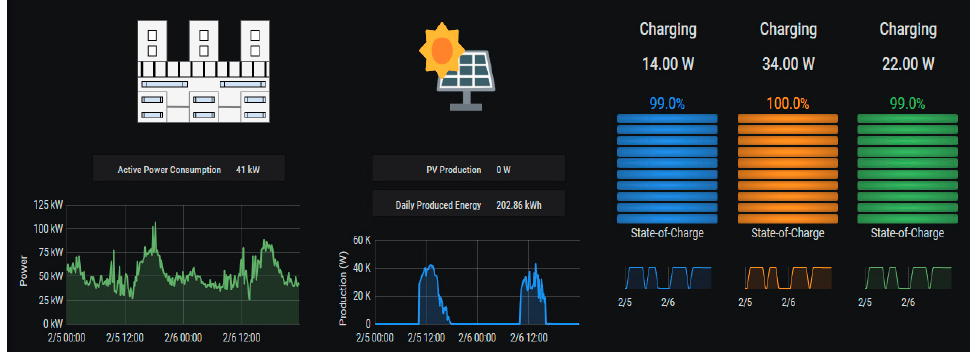
Figure 2. Microgrid monitoring system.